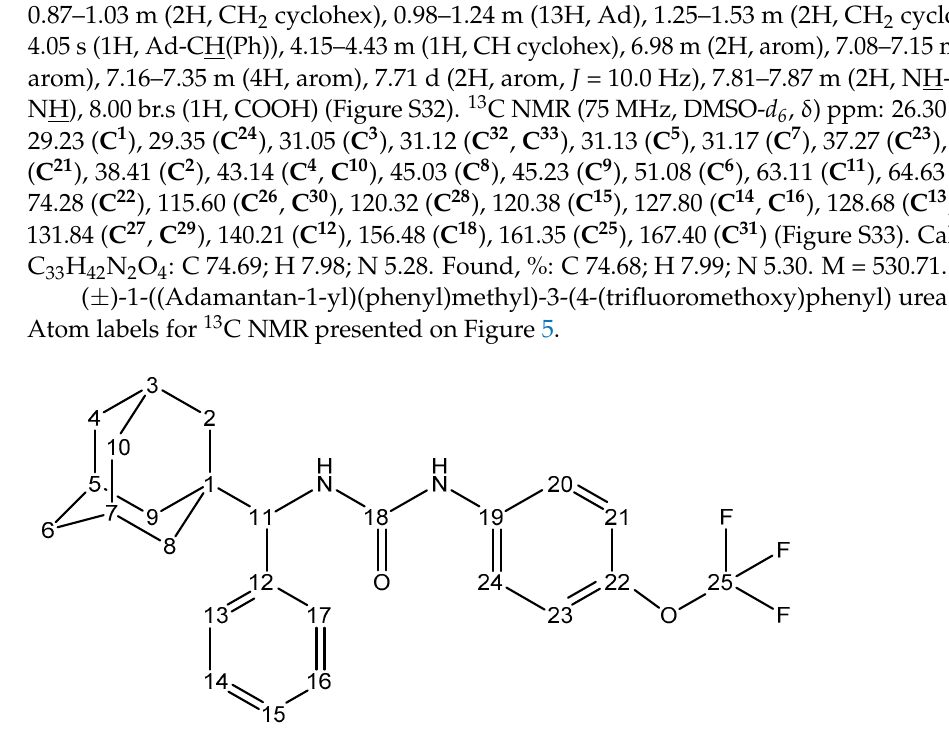
Figure 5. Carbon atoms labeled for compound 10a .